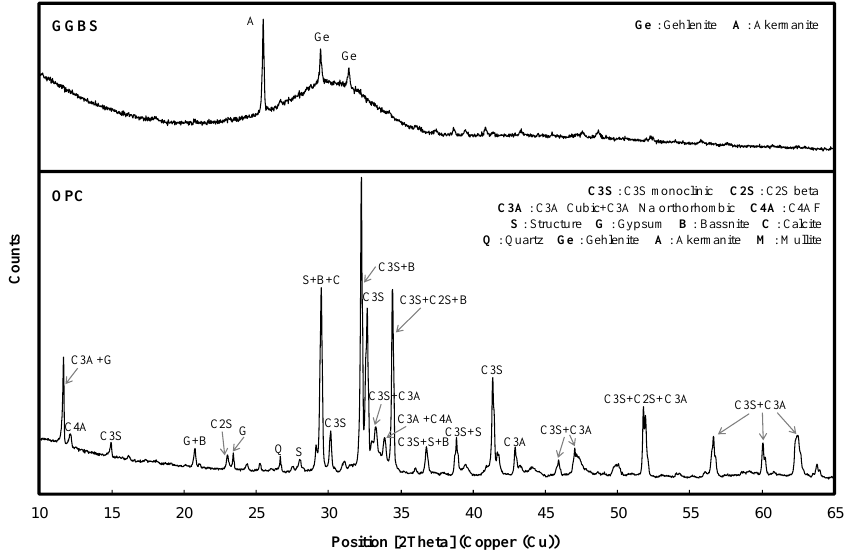
Figure 3. Gradation sieve analysis curves of aggregates used: ( a ) coarse aggregates and ( b ) fine aggregates.